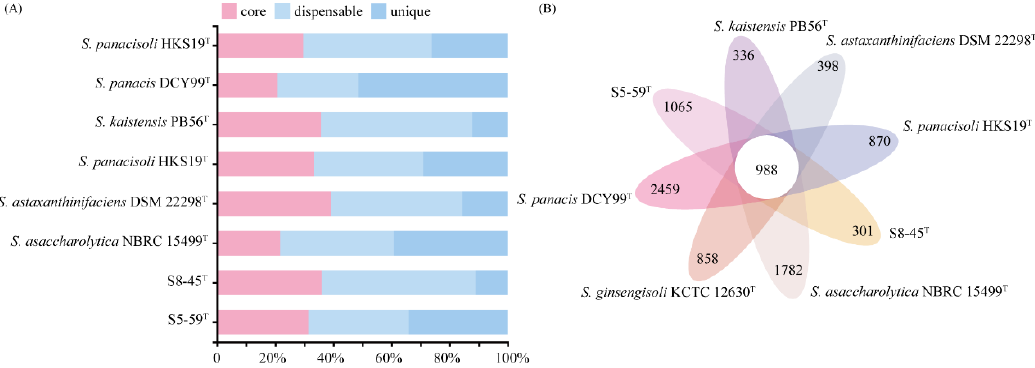
Figure 7. Comparisons of orthologous protein groups in S5-59 T , S8-45 T , and six related Sphingomonas genomes. ( A ) Percentage of core, dispensable, and unique genes in each of all eight genomes. ( B ) Venn diagram displaying the number of core and unique genes for each of the S5-59 T , S8-45 T , and related type strains.